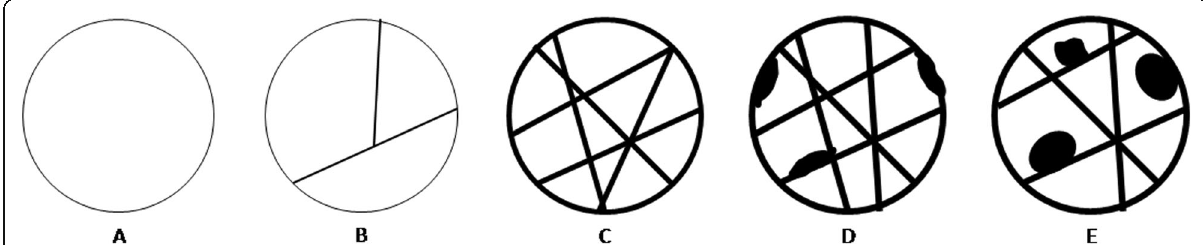
Fig. 2 Imaging features of cystic renal lesions according to Bosniak classification. a Bosniak category I cyst: thin wall. b Bosniak category II cyst: thin wall; few, thin septa. c Bosniak category II-F cyst: minimally thickened wall; several, minimally thickened septa. d Bosniak category III cyst: irregularly thickened wall; several, irregularly thickened septa. e Bosniak category IV cyst: enhancing nodularity; irregularly thickened wall; several, irregularly thickened